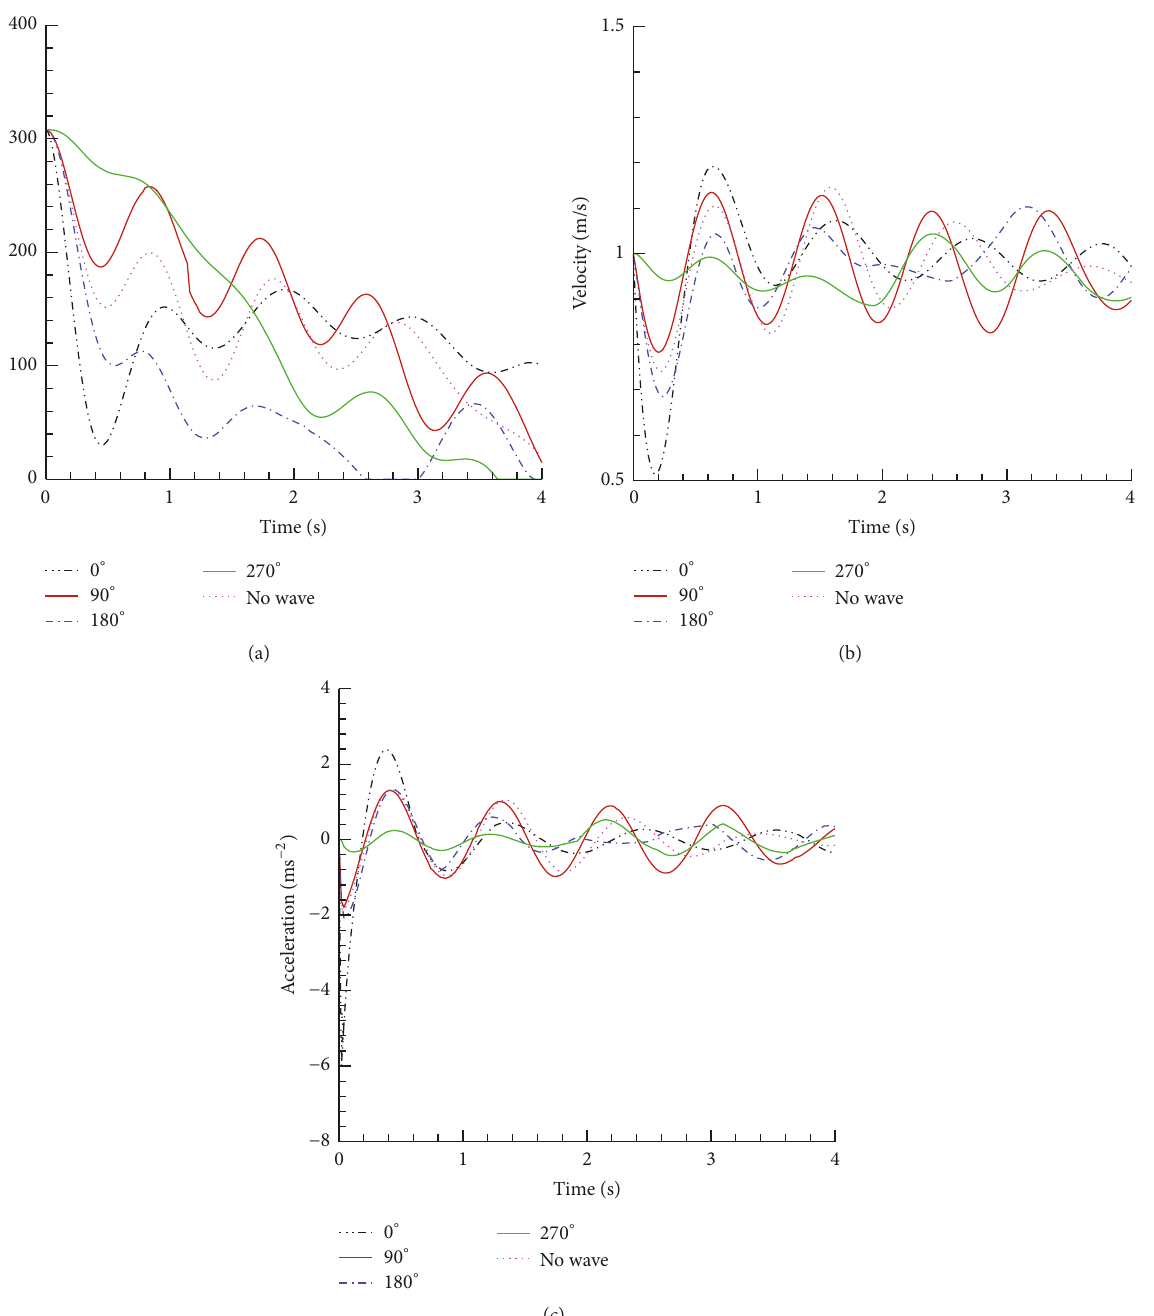
Figure 9: Influence of wave impact phase angles ( 𝑉 𝑑 = 1 m/s): (a) tension acting on the cylinder; (b) velocity of the cylinder; (c) acceleration of the